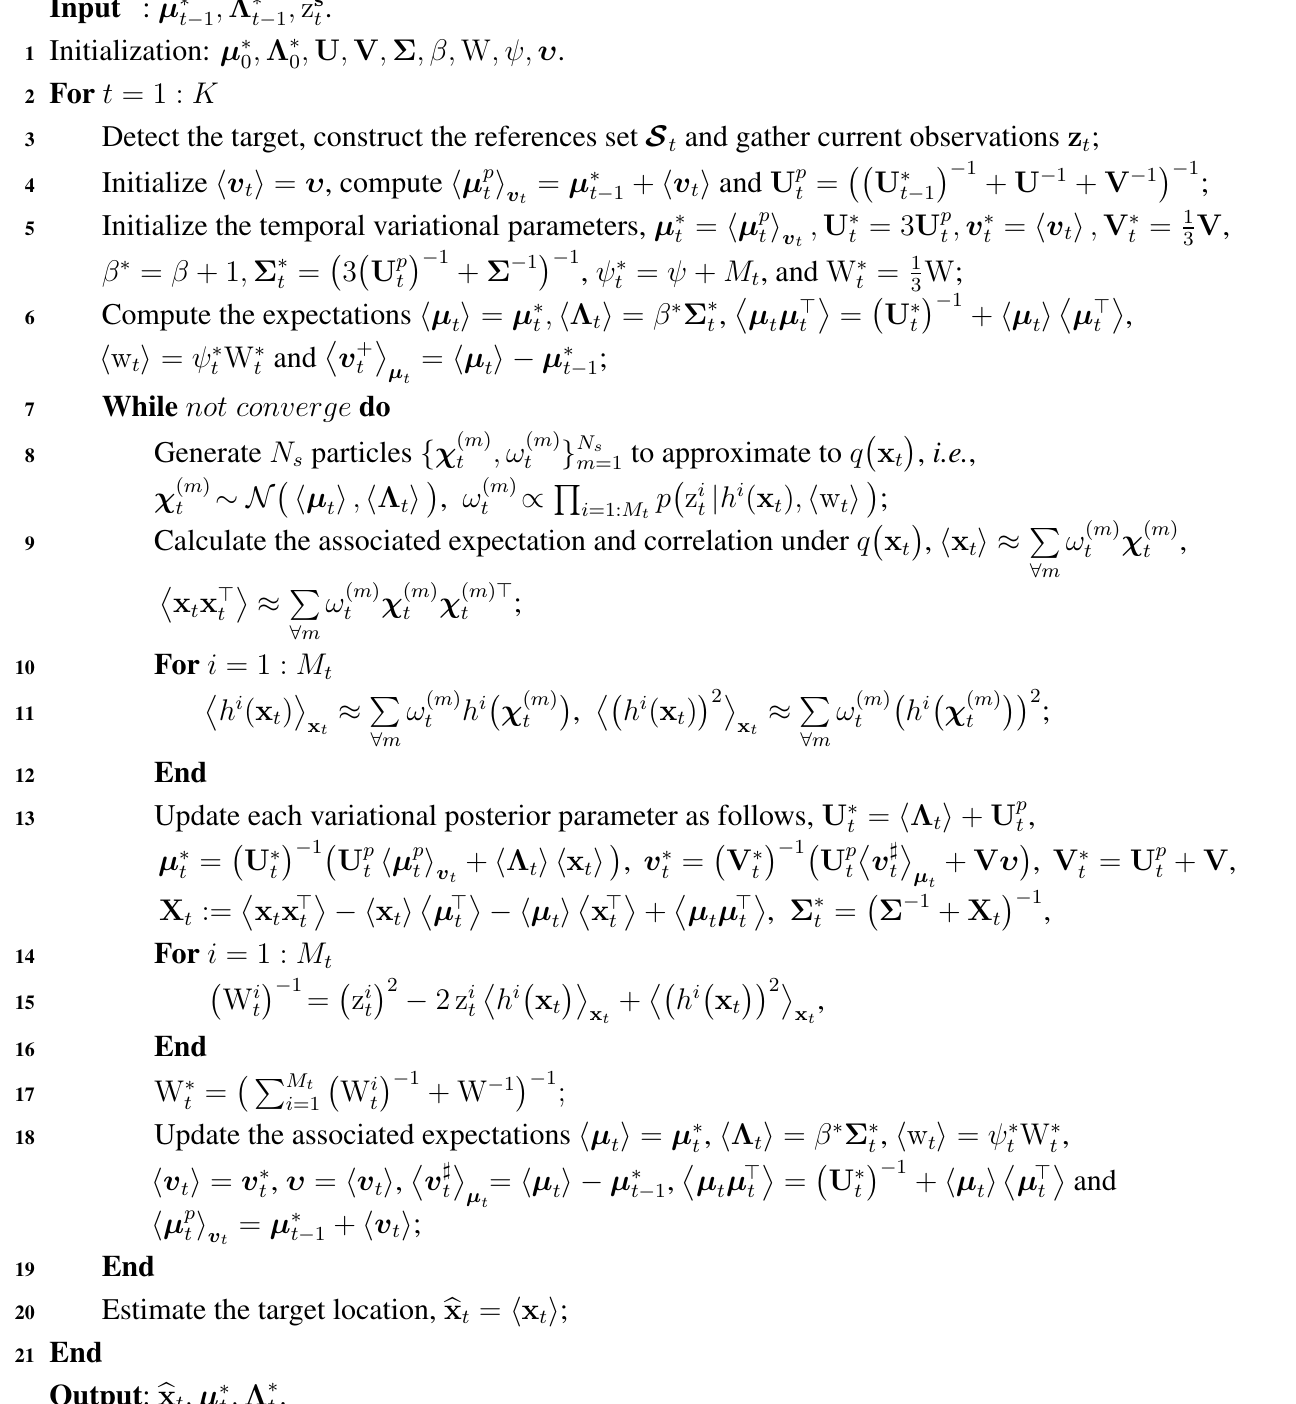
Algorithm 1: VBF - Online Target Tracking